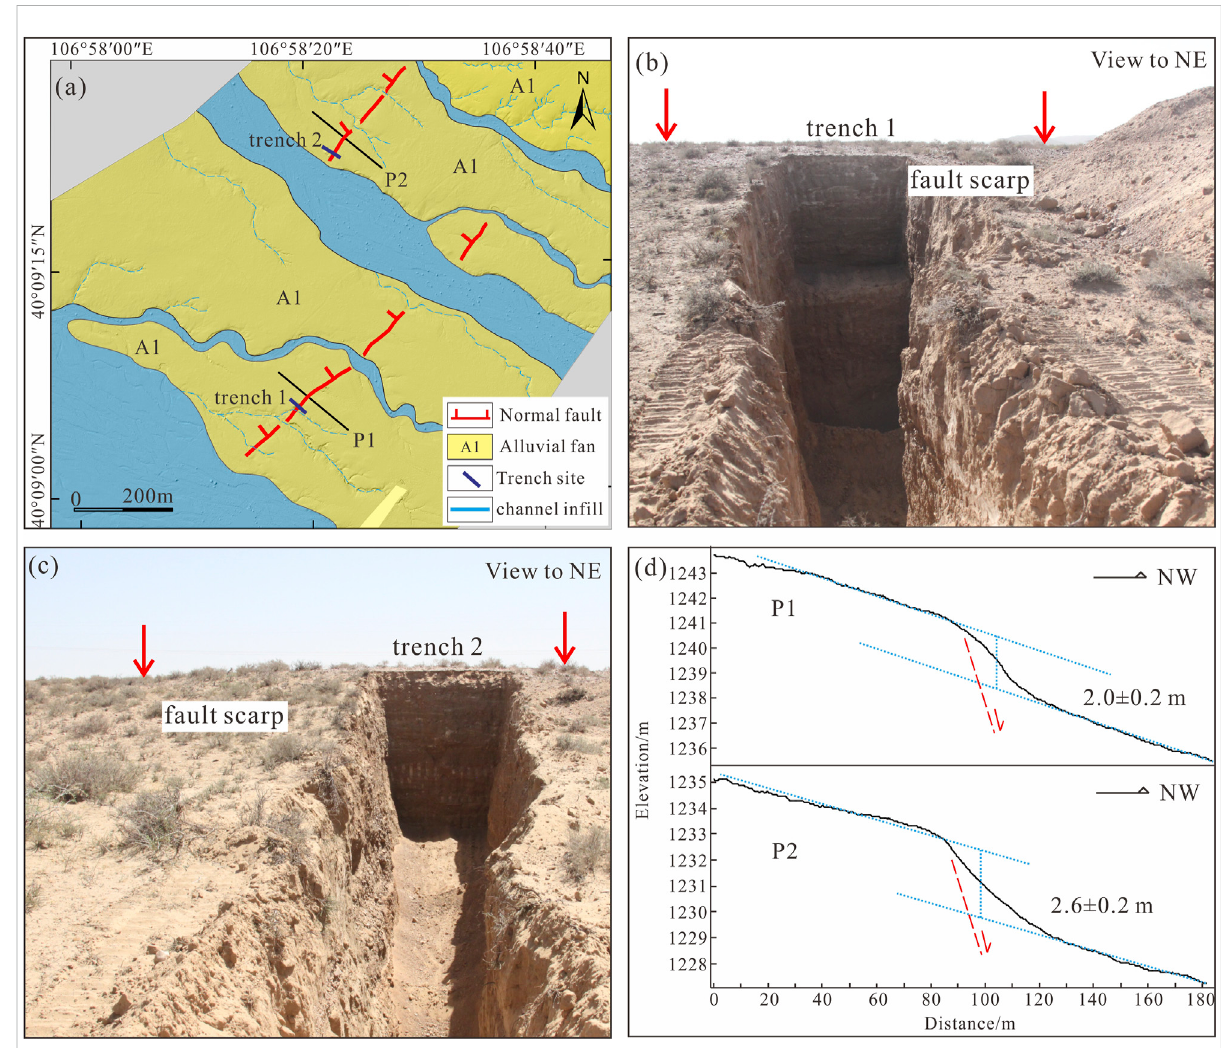
FIGURE 3 (A) Interpretation ofthehillshade map ofthetrench 1and trench 2sites; (B) faultscarp atthetrench 1site; (C) fault scarp atthetrench2site; (D) Topographic pro fi les across the fault scarp at the locations shown in panel (A) determined using a ~0.2 m resolution